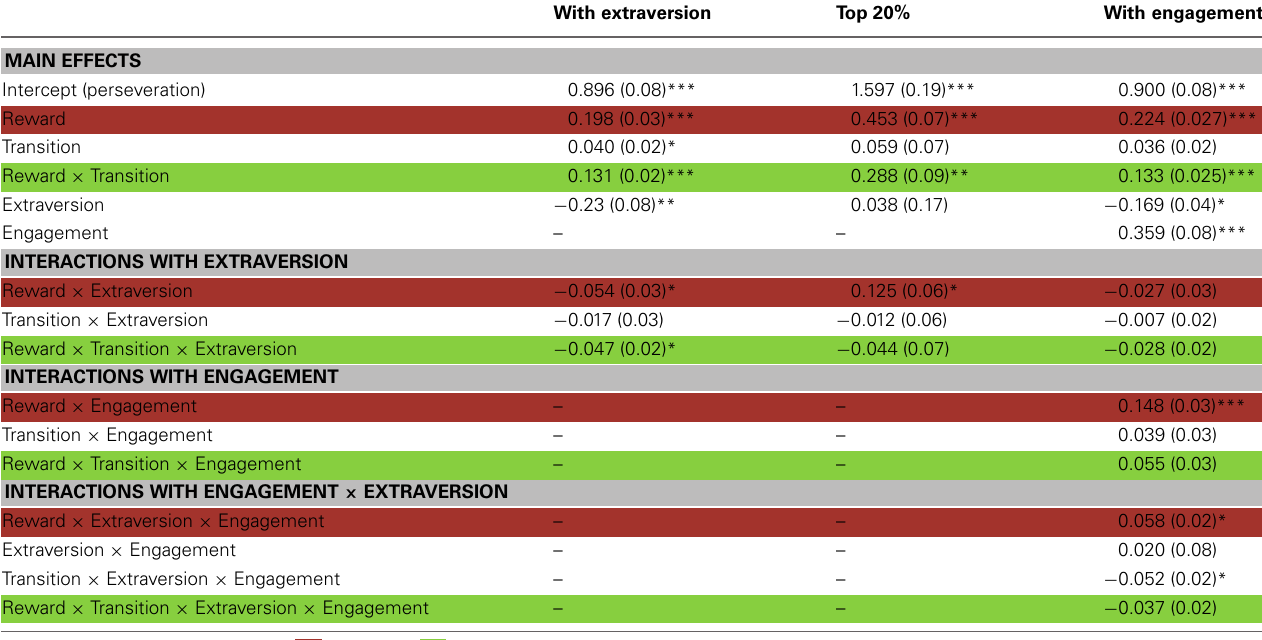
Table 1 | RL and extraversion effects for the overall sample of 97 participants, top 20%, and with engagement index: Beta coefficient estimates with standard errors from three mixed effects logistic regression